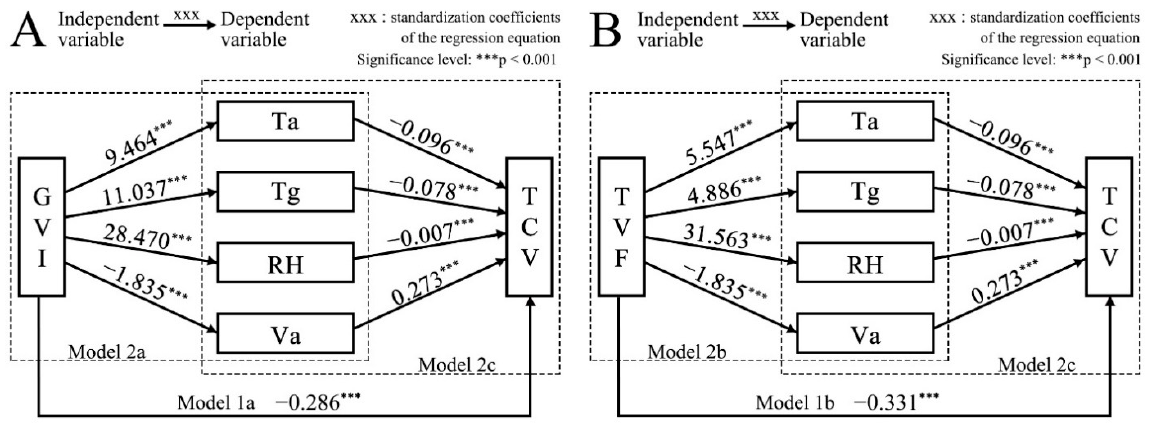
Figure 9. Results of regressing greenery on TCV, greenery on microclimate, and microclimate on